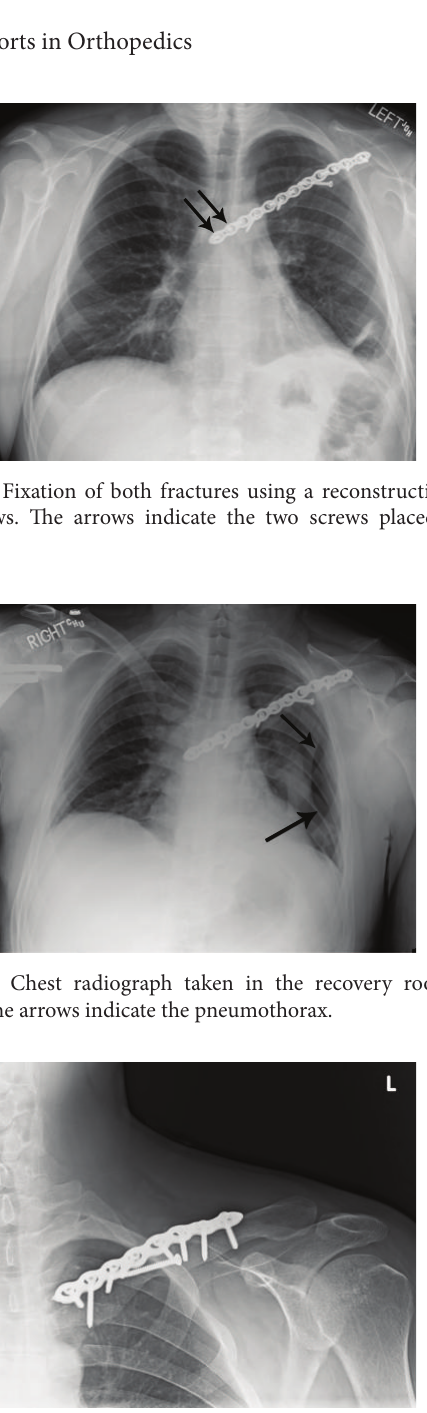
Figure 5: Radiographs taken after removing the medial one-third of the plate and four